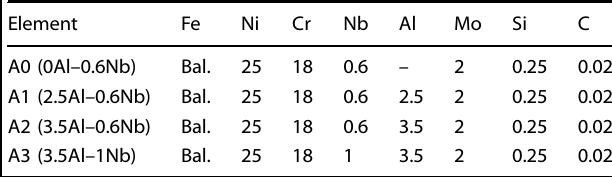
Table 1. Chemical compositions of experimental materials (wt.